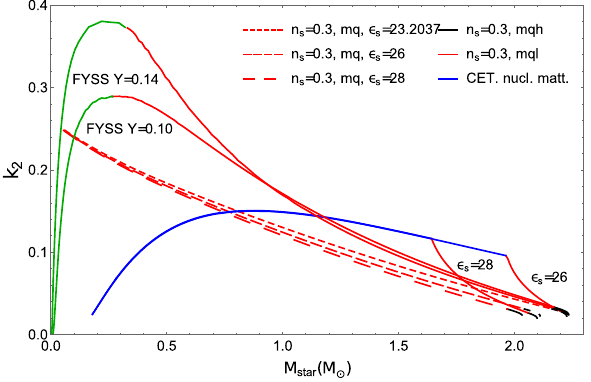
Fig. 1 Tidal Love number k 2 versus mass of MQS/NS with MQ core